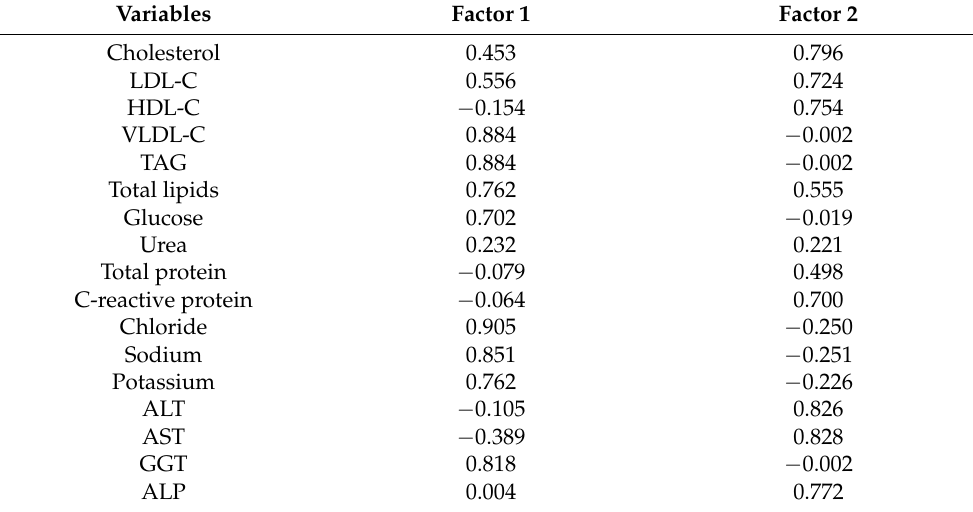
Table 5. Loadings for the first two principal factors of plasma